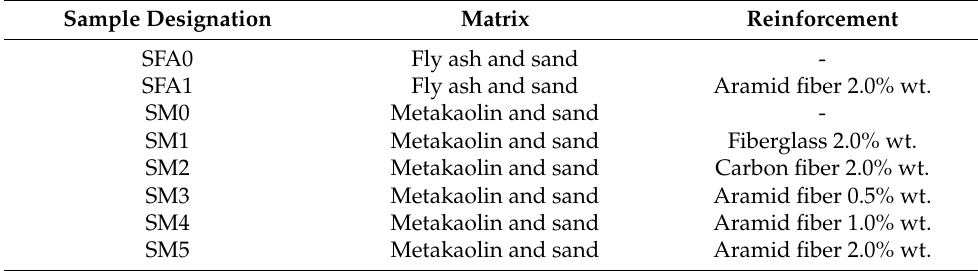
Table 1. Compositions of prepared samples.